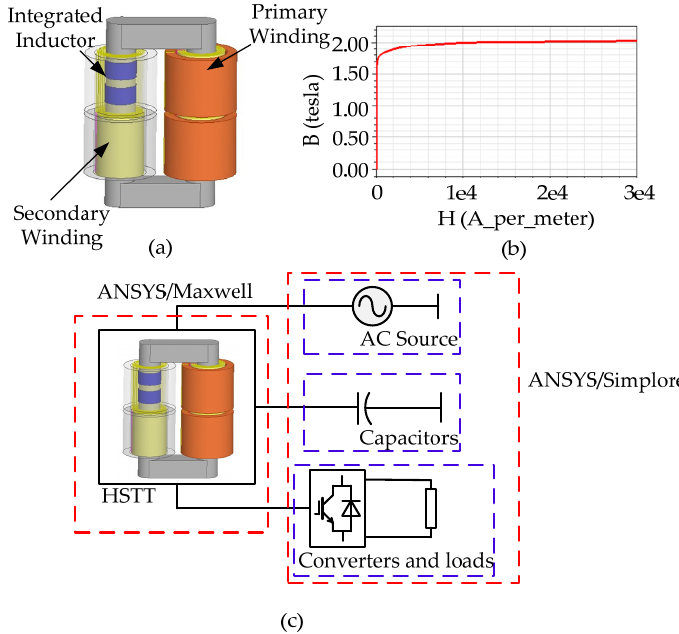
Figure 9. Field-circuit coupling simulations for the ( a ) 3D finite-element model of the HSTT, ( b ) B-H curve of the transformer core, and ( c ) model diagram. Table 1. Parameters of the HSTT with IFIs and traction drive system for simulation.